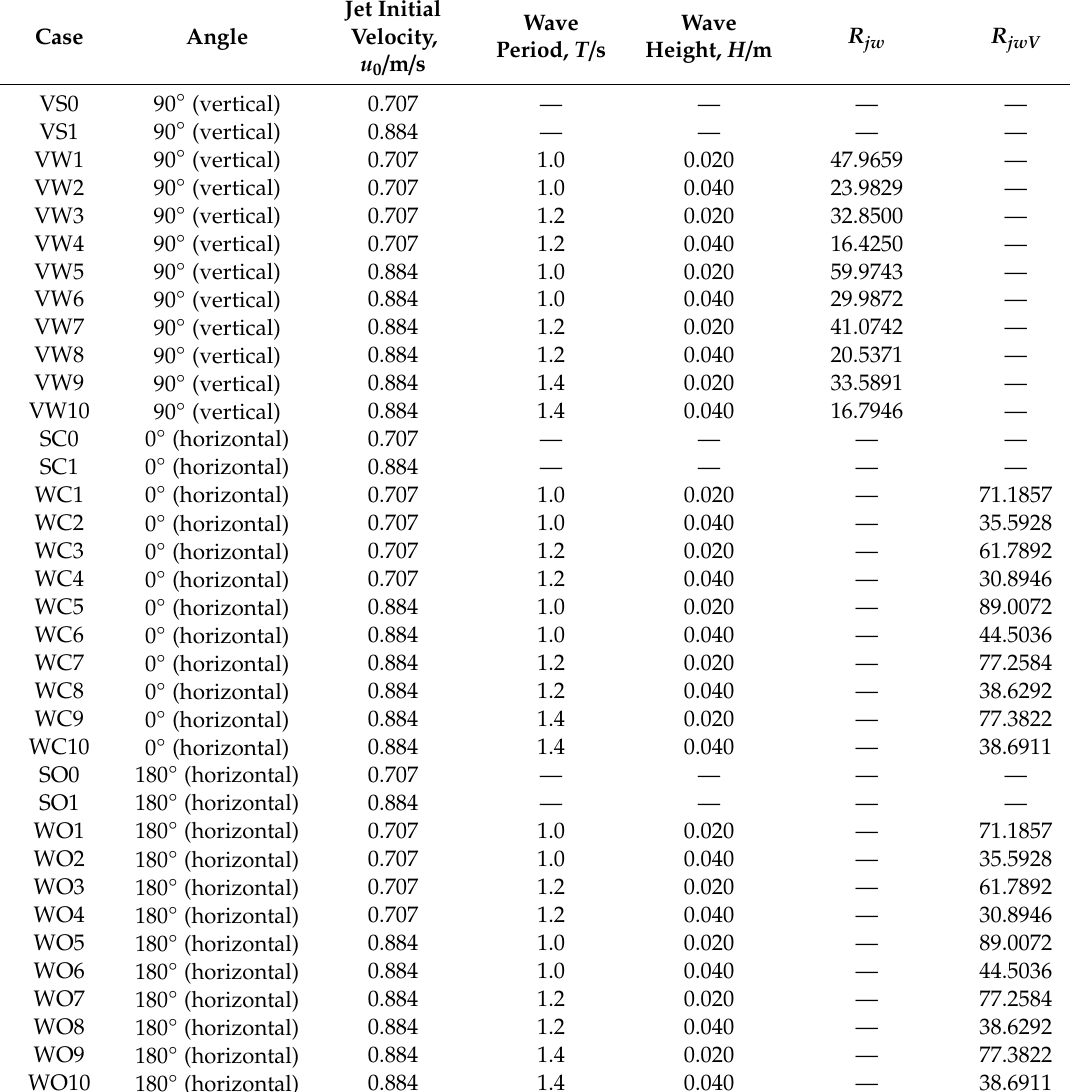
Table 1. List of experimental cases for the jet in stagnant water and wave